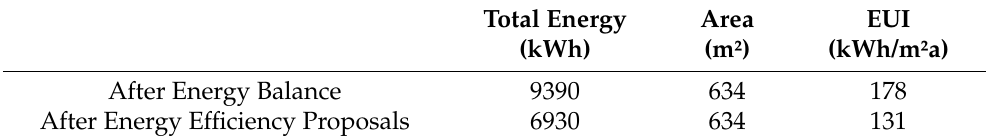
Table 8. Energy use